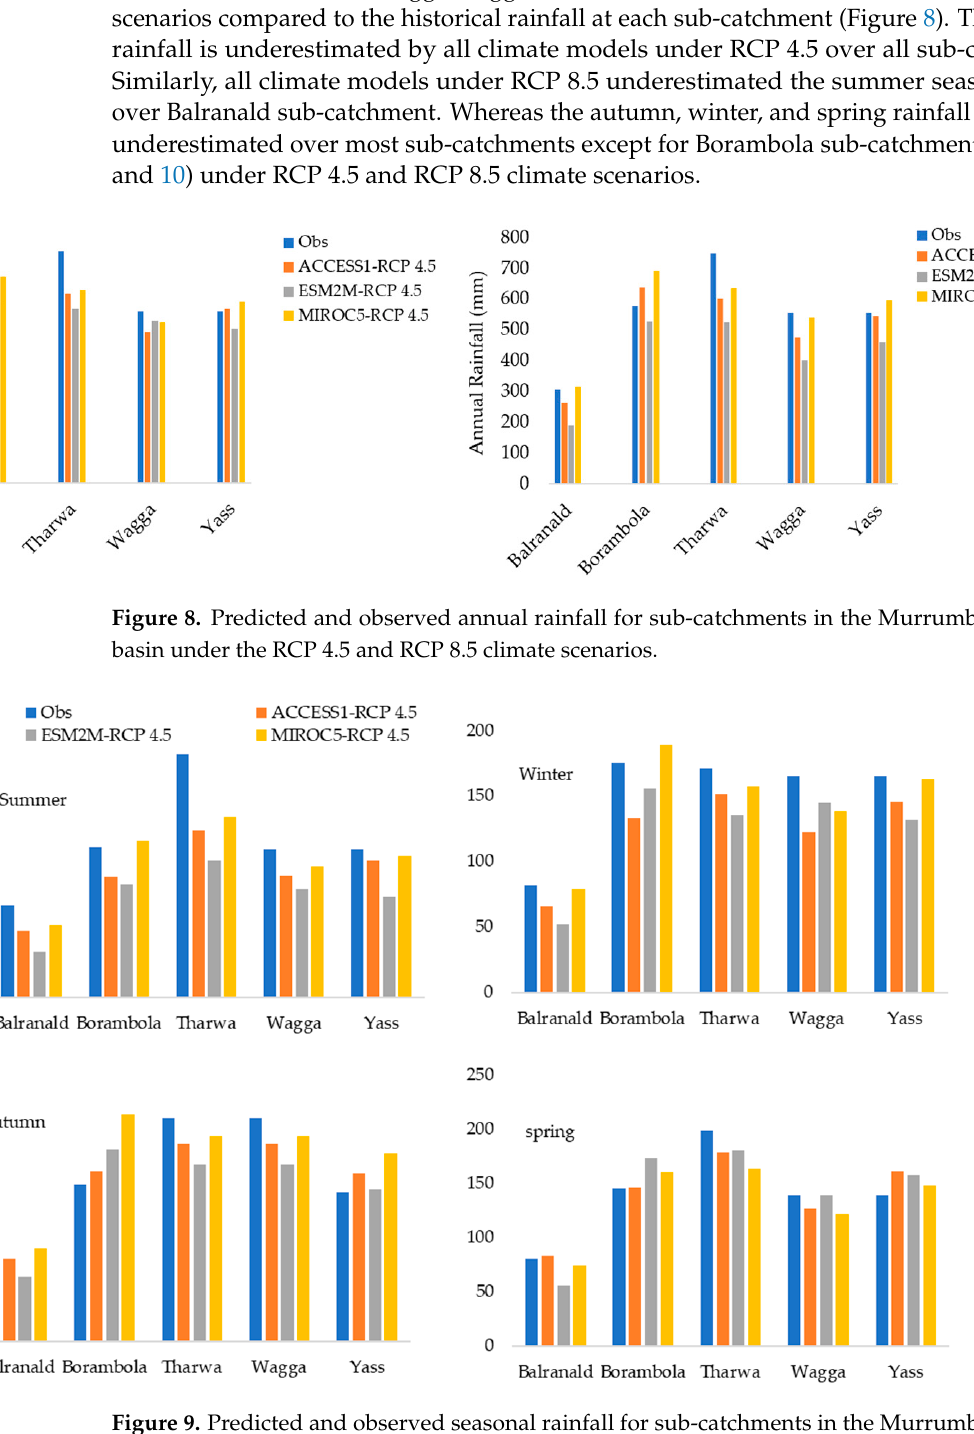
Figure 9. Predicted and observed seasonal rainfall for sub-catchments in the Murrumbidgee River basin under the RCP 4.5 climate scenario.